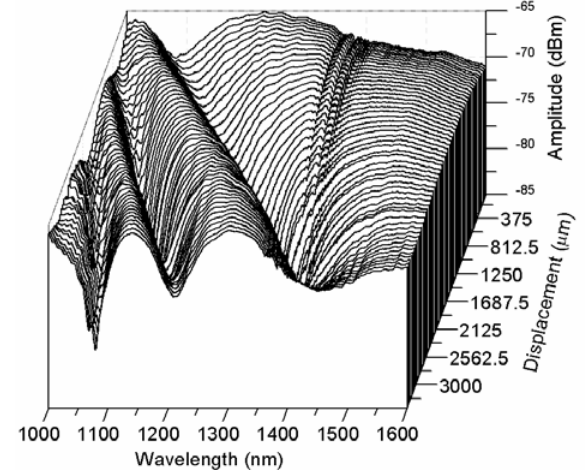
Figure 3. Waterfall plot of the spectral evolution of the fiber-loop displacement